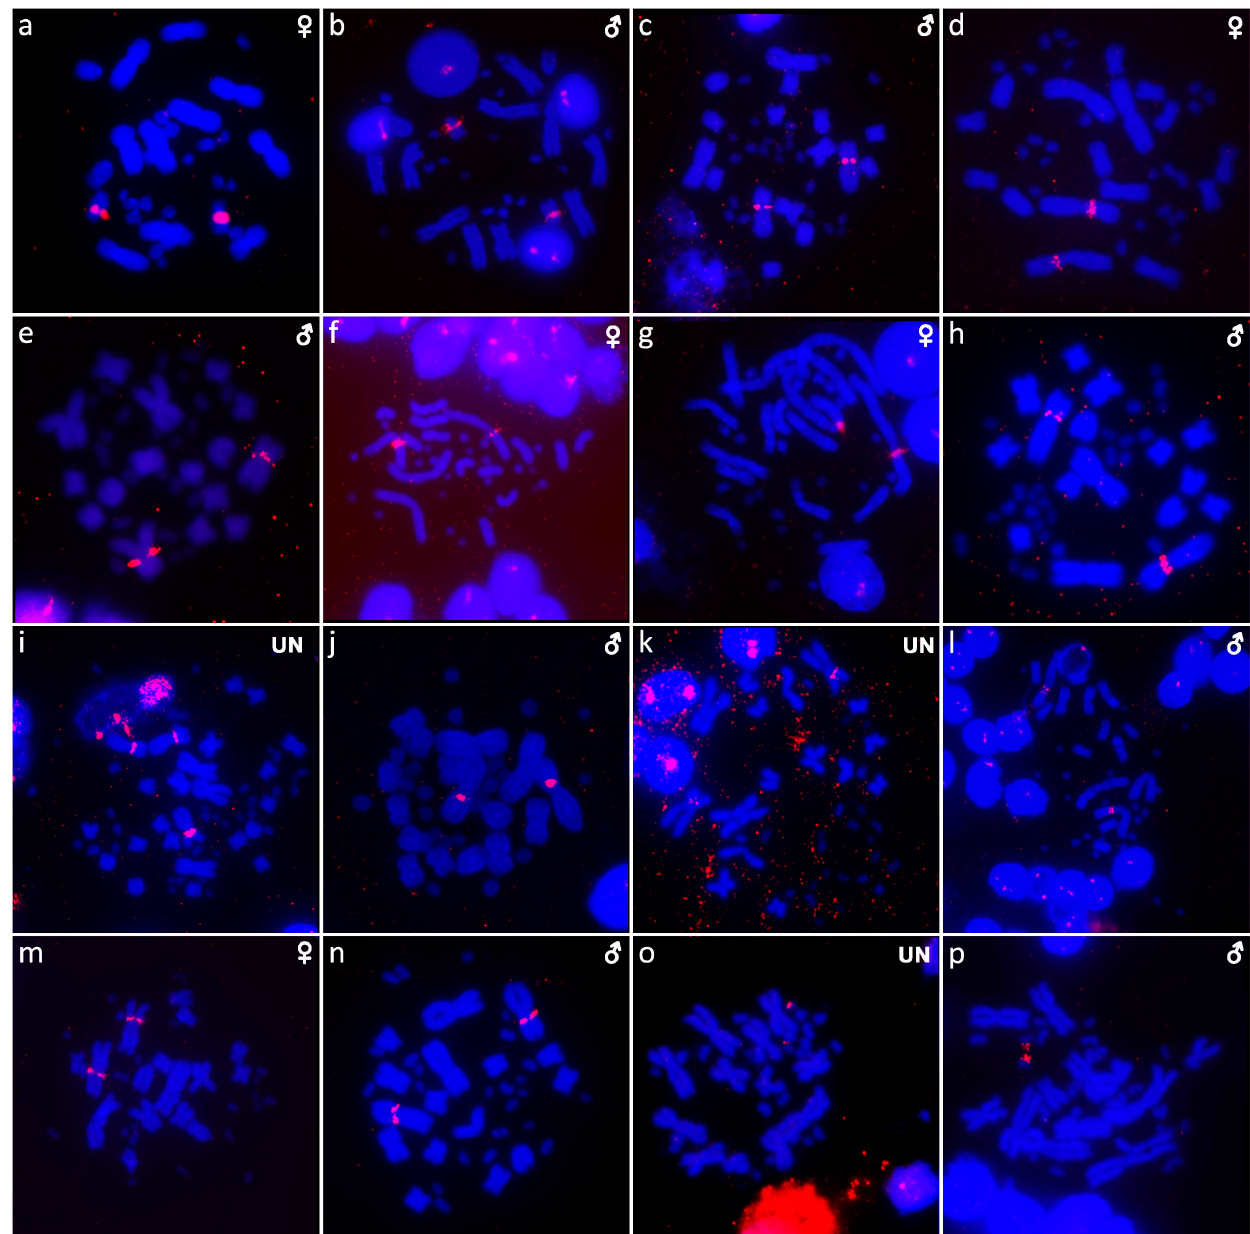
Figure 9. In situ hybridization with probe for 18S/28S rDNA loci in Shinisaurus crocodilurus ( a , b ), Varanus auffenbergi ( c ), Varanus cumingi ( d , e ), Varanus kordensis ( f ), Varanus primordius ( g , h ), Varanus olivaceus ( i , j ), Varanus salvadorii ( k , l ), Varanus salvator komaini ( m , n ), Xenosaurus platyceps ( o ) and Xenosaurus rectocollaris ( p ). UN: sex not known.